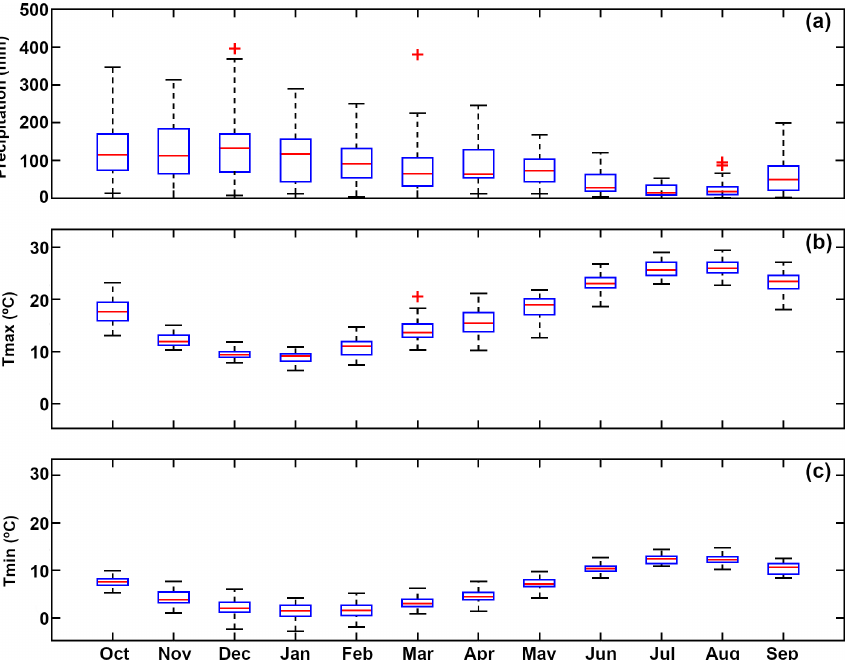
Figure 2. The annual cycle for the hydrological year spanning October of year n to September of year n + 1, for the period of 1980–2017, for (a) monthly mean precipitation, (b) maximum temperature, and (c) minimum temperature in the MLSHD, using the E-OBS gridded dataset. Boxes delineate the median (red line), upper, and lower quartiles, with the whiskers representing the lowest and highest monthly value still within 1.5 of the interquartile range. Outliers, i.e. values beyond the ends of the whiskers, are denoted by a +